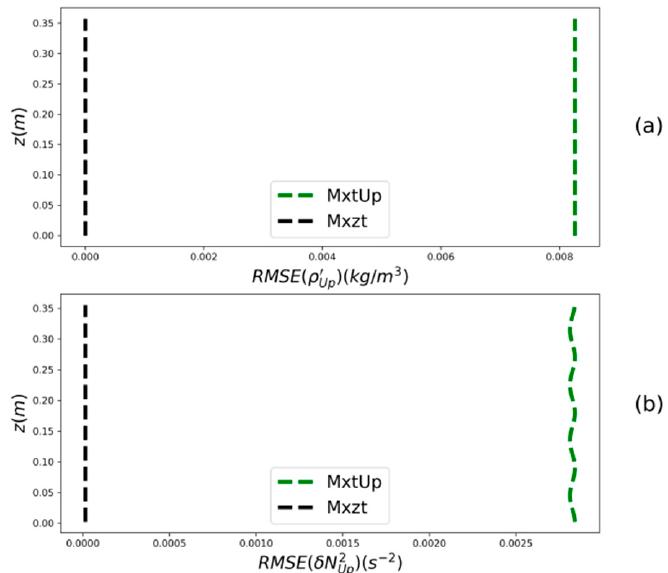
Figure 4. Vertical profiles of the rms error, averaged over x and t , of the reconstructed upward propagating wave fields of IW mix resulting from the Mxzt and MxtUp methods. ( a ) rms error of δρ . ( b ) rms error of δ N 2 .